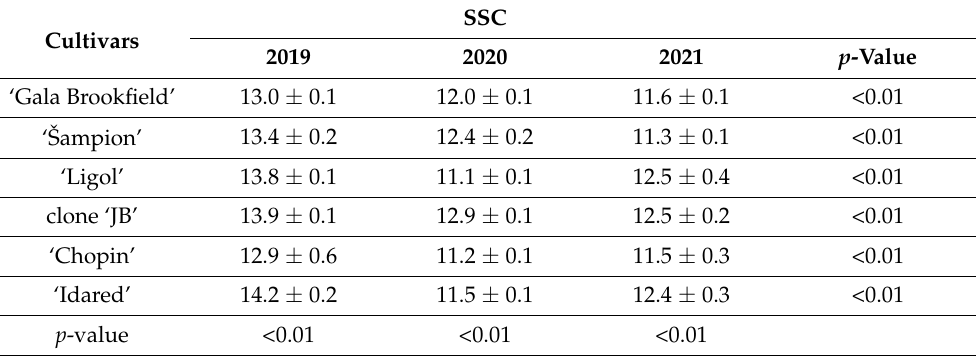
Table 3. The values of solids soluble content ( ◦ Brix) for apples depending on cultivars and years of